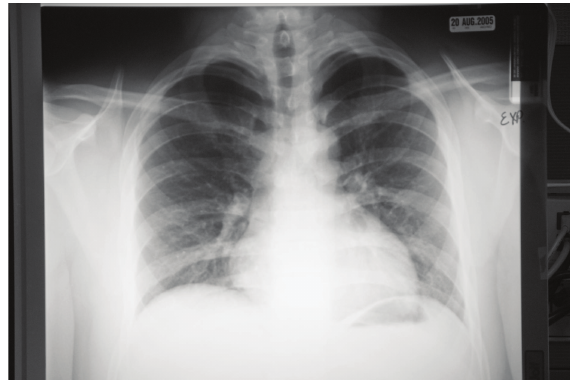
Figure 2: Follow-up chest X-ray, expiratory view, two weeks later, shows resolution of previous